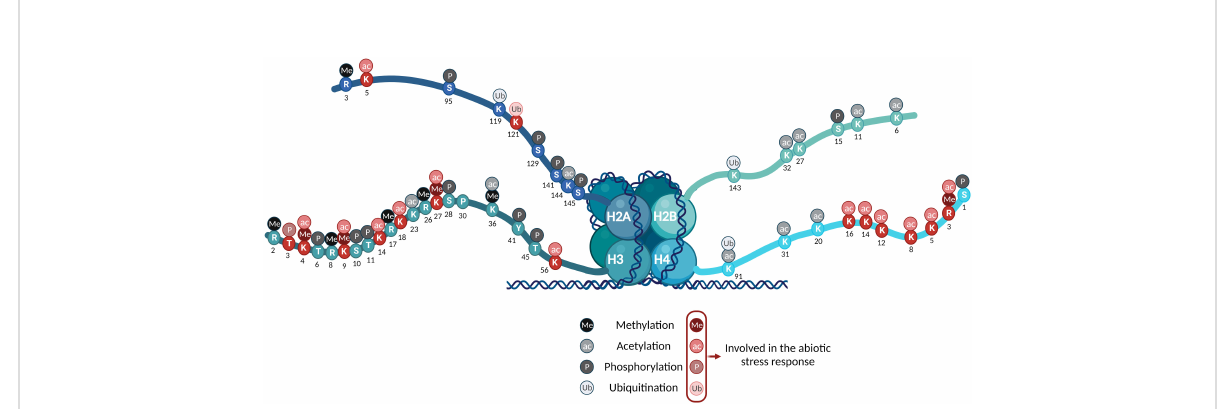
FIGURE 3 Summary of the histone PTMs in the nucleosome ’ s core histones in Arabidopsis . The PTMs detected are color-coded as indicated. Those involved in the abiotic stress response are highlighted in